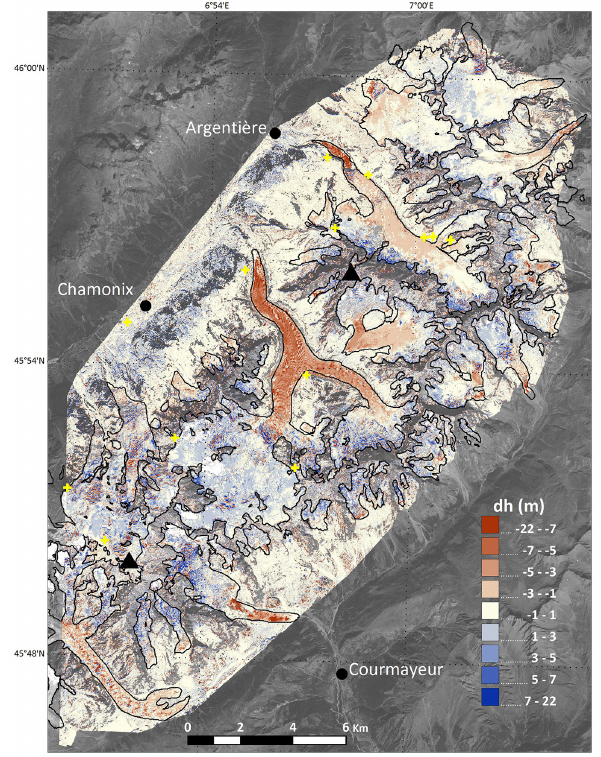
Figure 7. Elevation differences between the Pléiades DEMs of 19 August 2012 and 20 September 2013 over the Mont-Blanc area. The outlines of glaciers in August 2003 are shown as black lines. Yellow crosses show the location of GCPs. The southernmost trian- gle locates the summit of Mont Blanc (4810ma.s.l.) and the north- ernmost triangle the summit of Aiguille Verte (4122ma.s.l.). The grey background SPOT 5 image ( © CNES 2003, Distribution Spot Image) appears where no elevation change value is